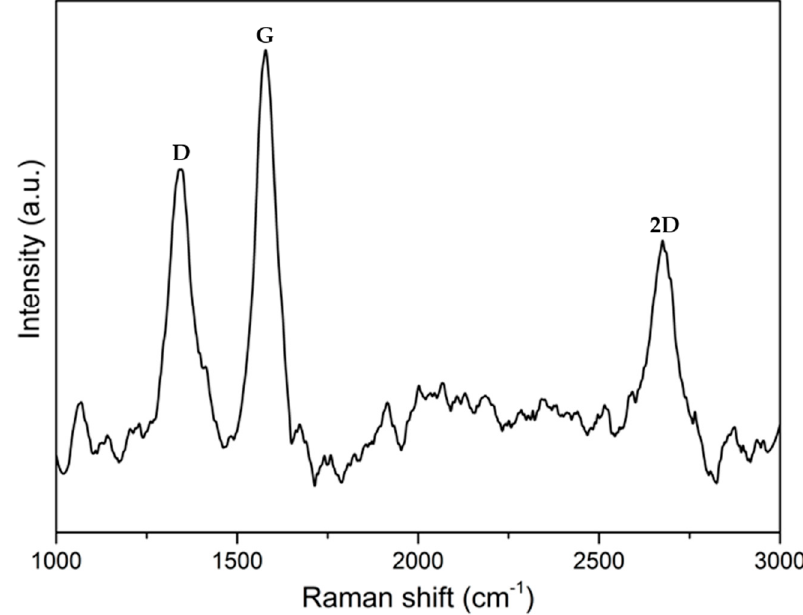
Figure A7. Raman spectra of ZIF67C_1000.